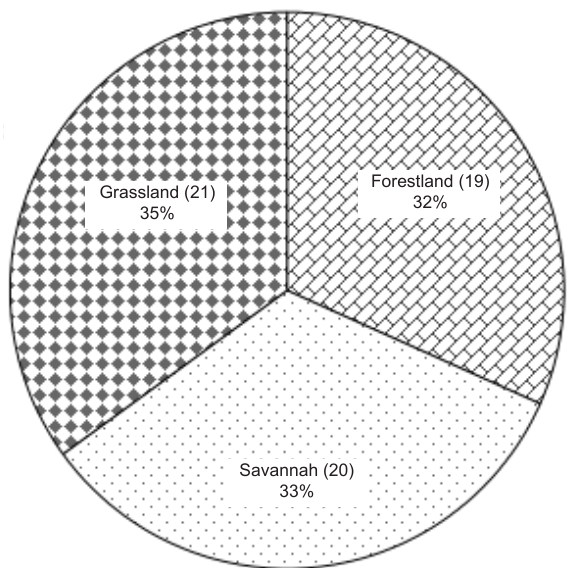
Figure 2. Orthopteroid species richness with reference to habitat types in Kaziranga National Park, Assam